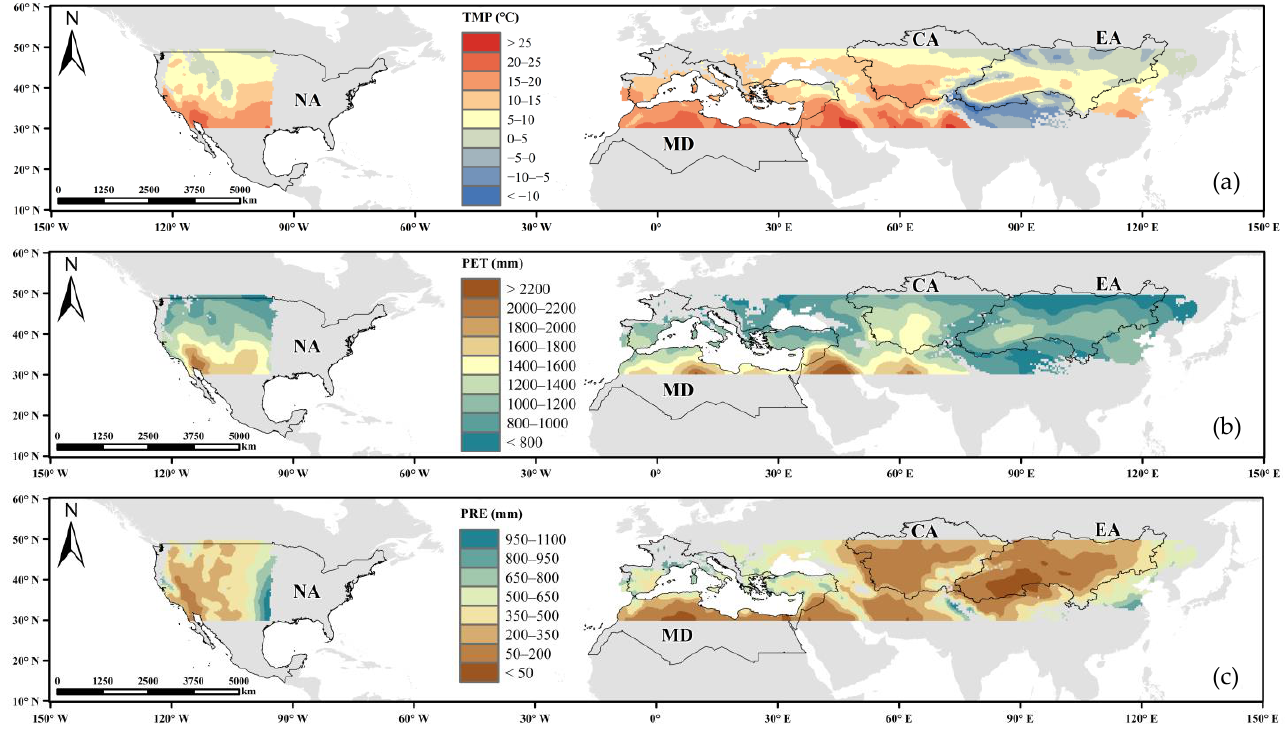
Figure 3. Spatial distribution of the average annual temperature (TMP) ( a ), potential evapotranspi- ration (PET) ( b ), and precipitation (PRE) ( c ) over the study area from 1981 to 2018.